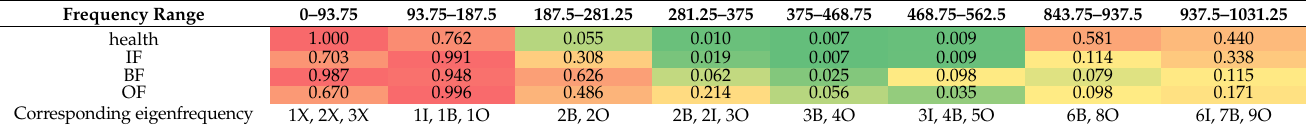
Table 8. Summary and average of attention weights for working conditions (where 1X represents 1 multiplier of power frequency, 2I represents 2 multiplier of IF, and so on) (The shade of the color represents the magnitude of the attention factor, with red representing a larger factor and green representing a smaller